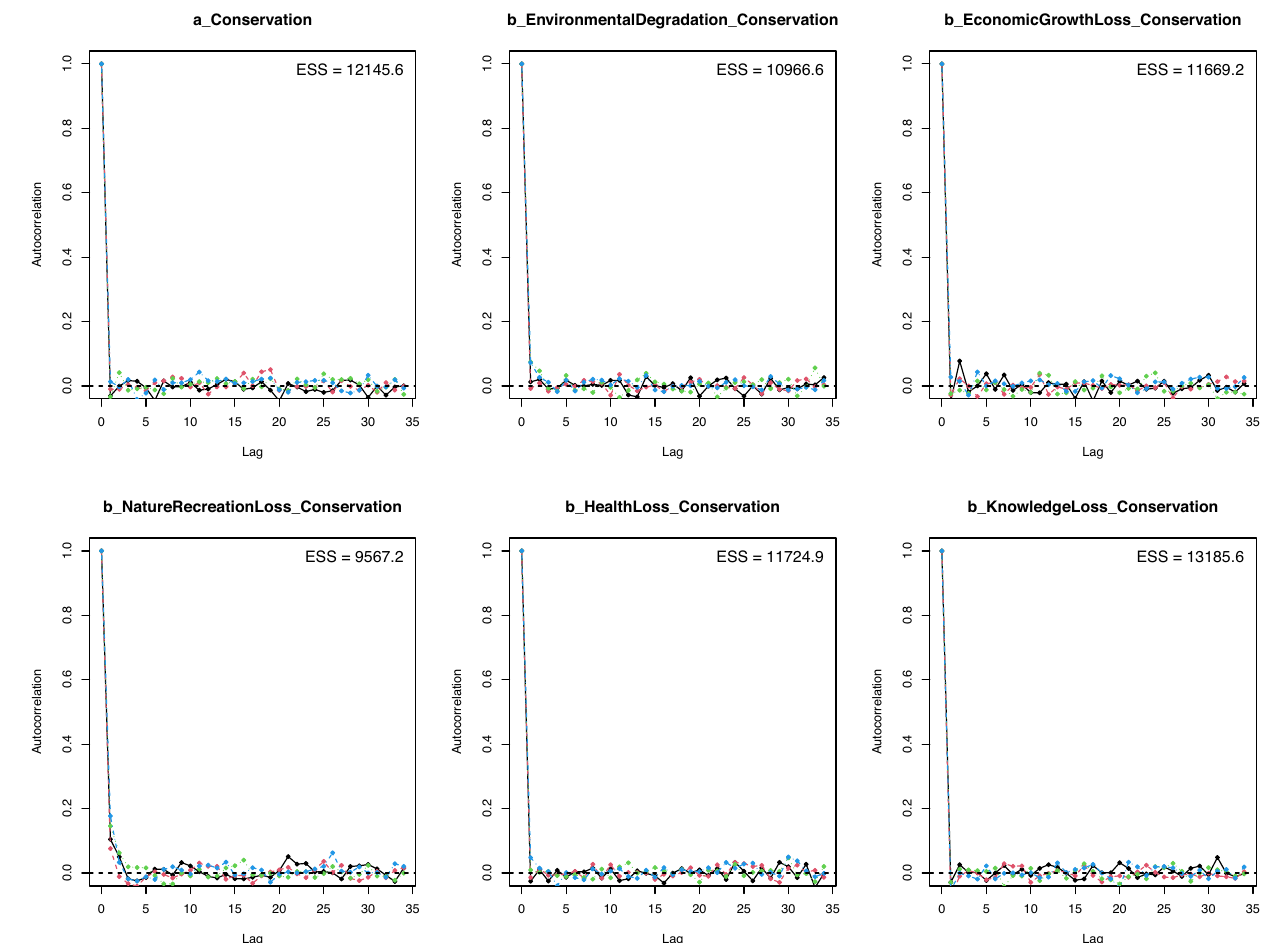
Fig. 5 Model 1 ’ s autocorrelation plots with priors as norm (1,0.5). If the autocorrelation levels among iterative samples drop to 0 after some fi nite lags, the iterative samples are considered independent, and the Markov chains are deemed